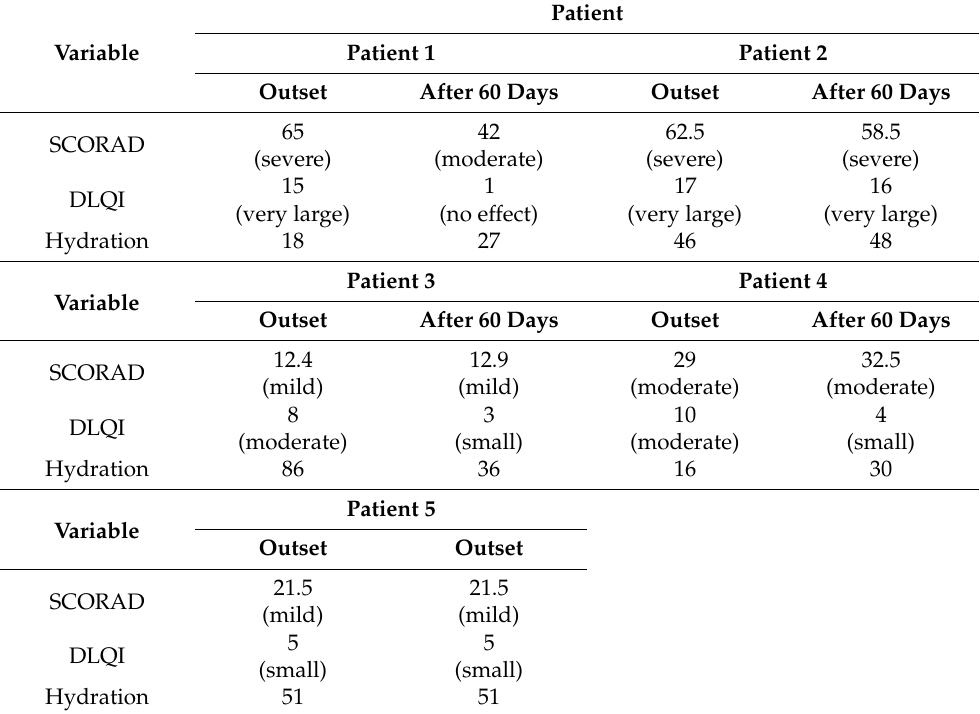
Table 7. SCORAD, DLQI, and skin hydration of each patient treated with CPropolis (Intervention). Variable